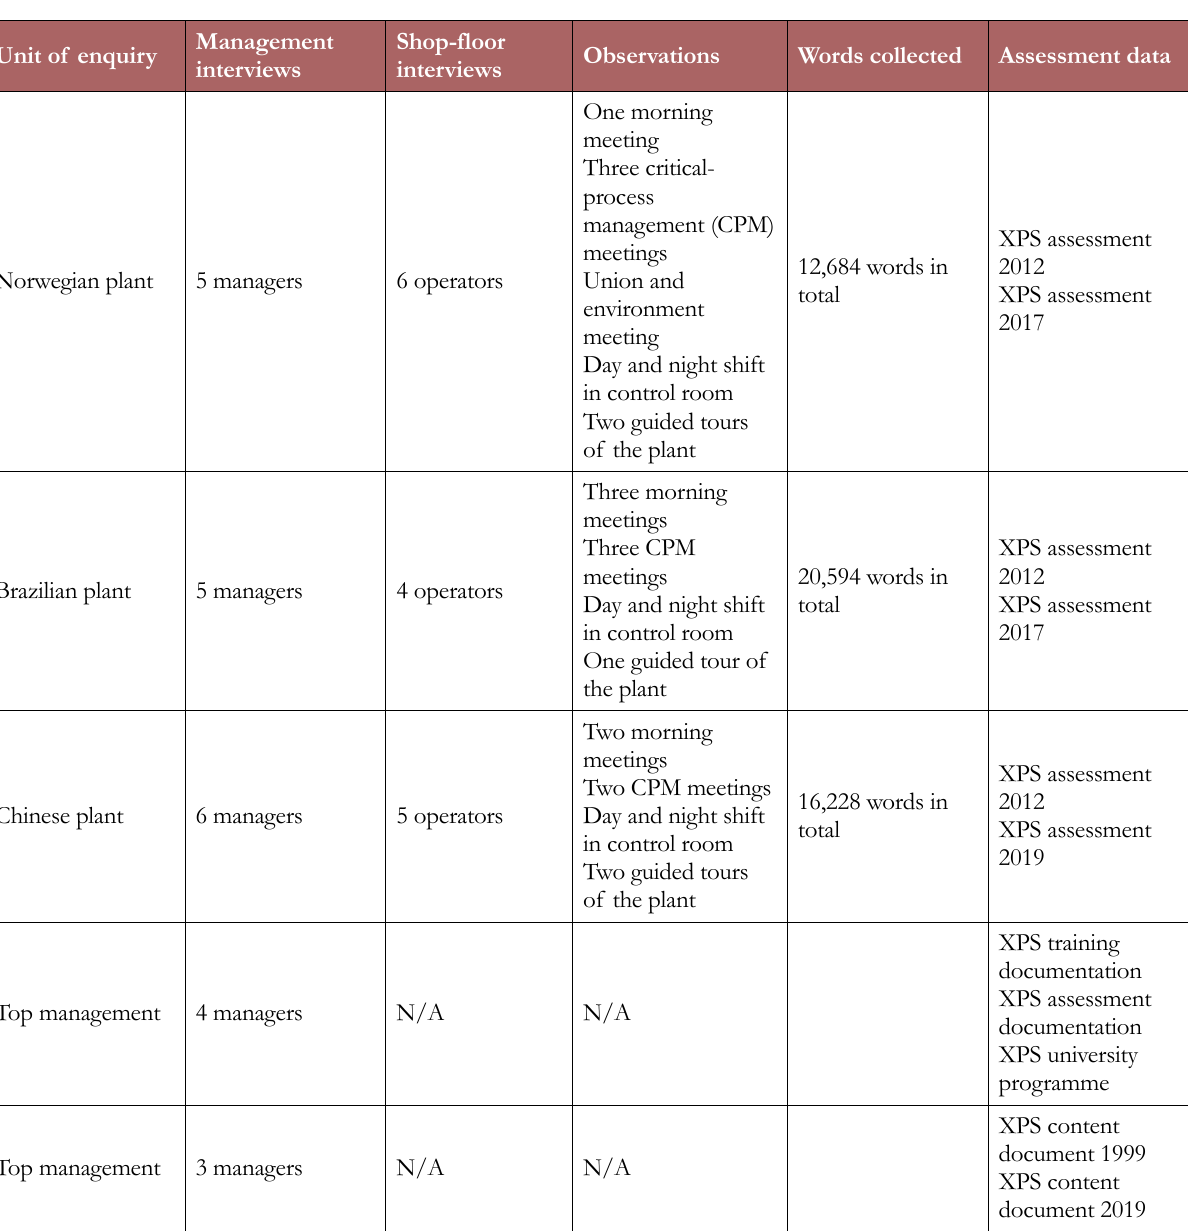
Table 2. Overview of qualitative data. Words collected refer to interview